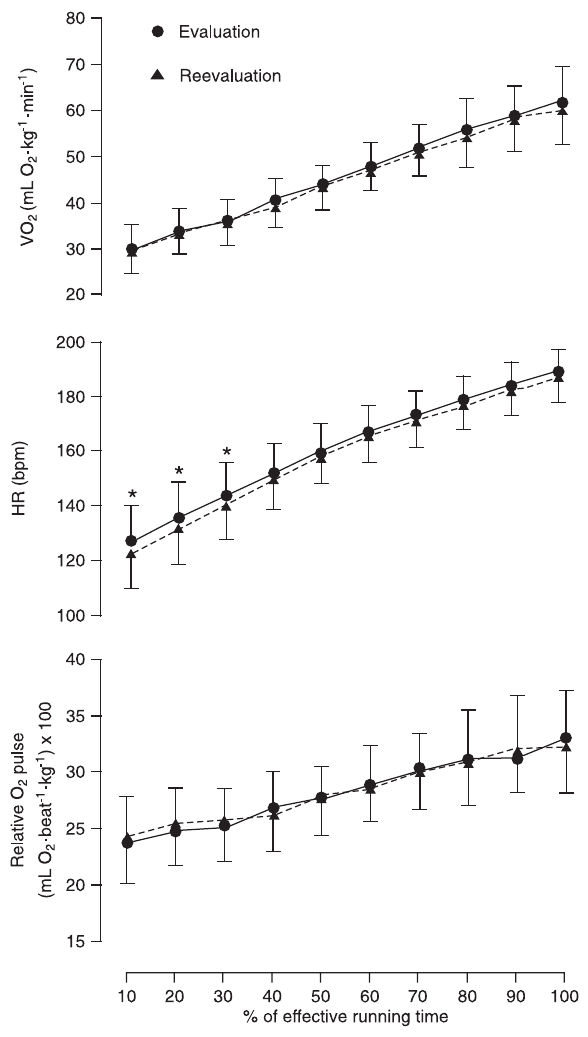
Figure 1. Oxygen consumption (VO 2 ), heart rate (HR), and rela - tive O 2 pulse curves expressed as a function of percent duration of cardiopulmonary exercise testing. *P < 0.05 compared to the first evaluation (two-way